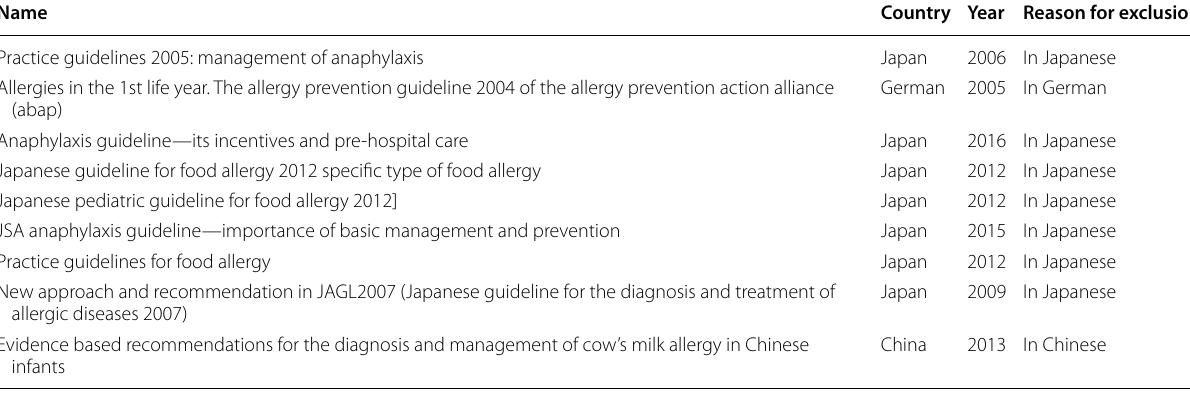
Table 4 National guidelines that we were unable to formally